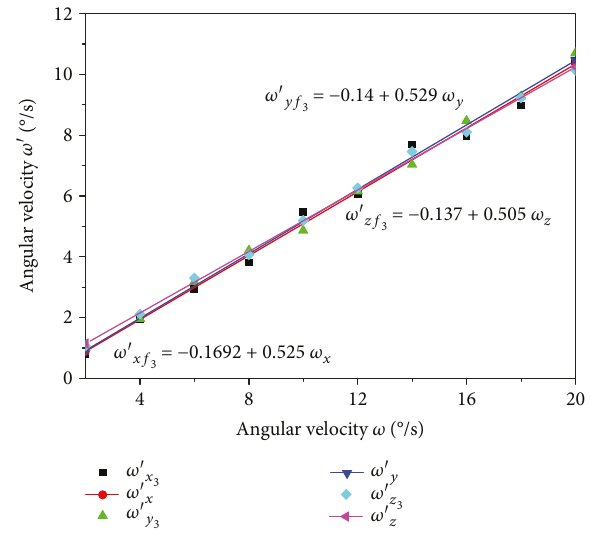
Figure 10: Fitting polynomial and fi tting results of empty storage ′ , ω ′ , and ω ′ of the linear regression equations. Table 14: ω xf 3 yf 3 zf 3